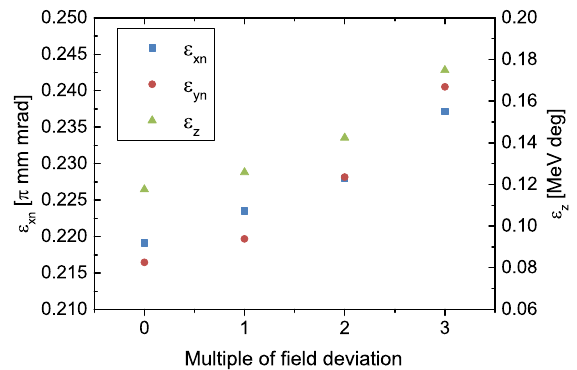
FIG. 22. Output transverse and longitudinal emittance at differ- ent multiples of the field